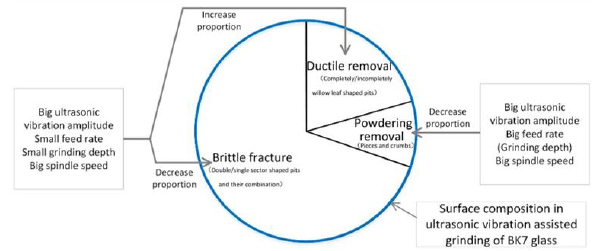
Figure 9. Effect of processing parameters on surface composition in ultrasonic vibration assisted grinding of optical glass BK7.